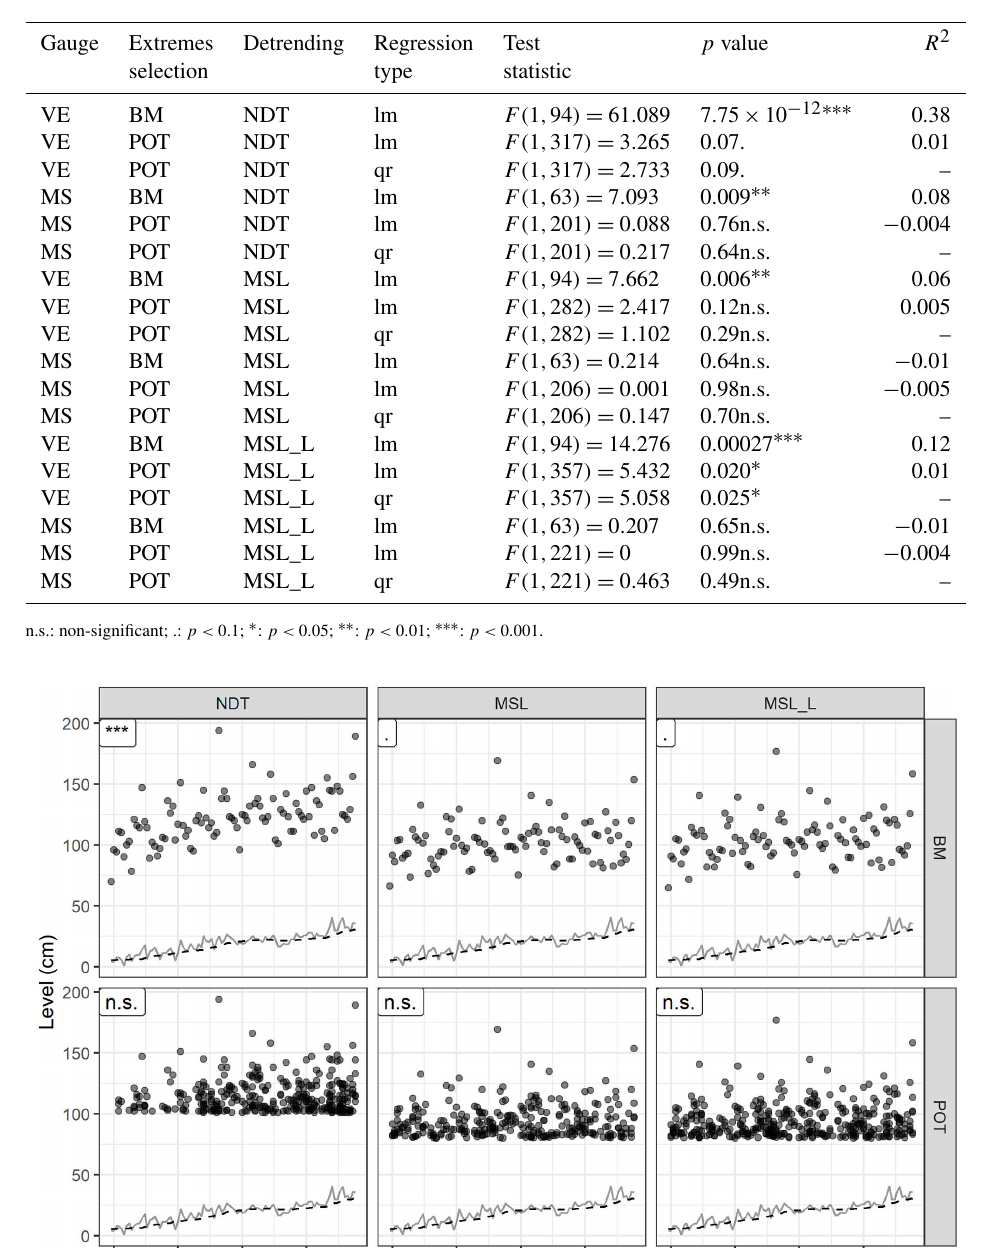
Table 1. Trend in the data used to fit the models. lm: linear model; qr: quantile regression (75th data quantile). VE denotes Venice; MS denotes Marseille.